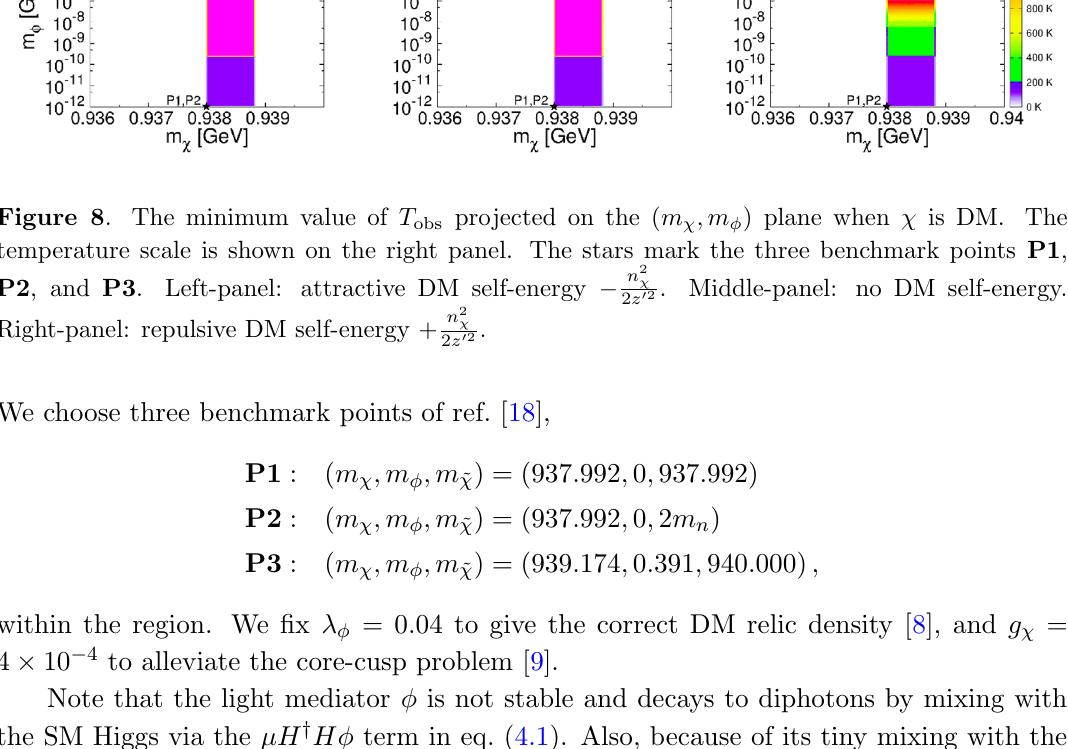
2 (cid:31) . Middle-panel: no DM self-energy. 2 z 0 2 2 (cid:31) 2 z 0 2